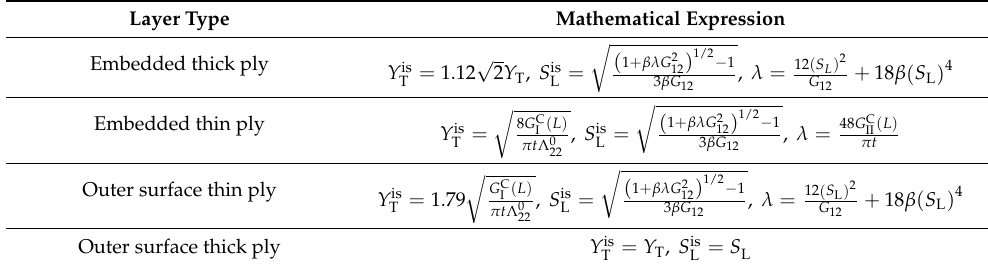
Table 2. Expressions of in situ transverse tensile and shear strength [21].